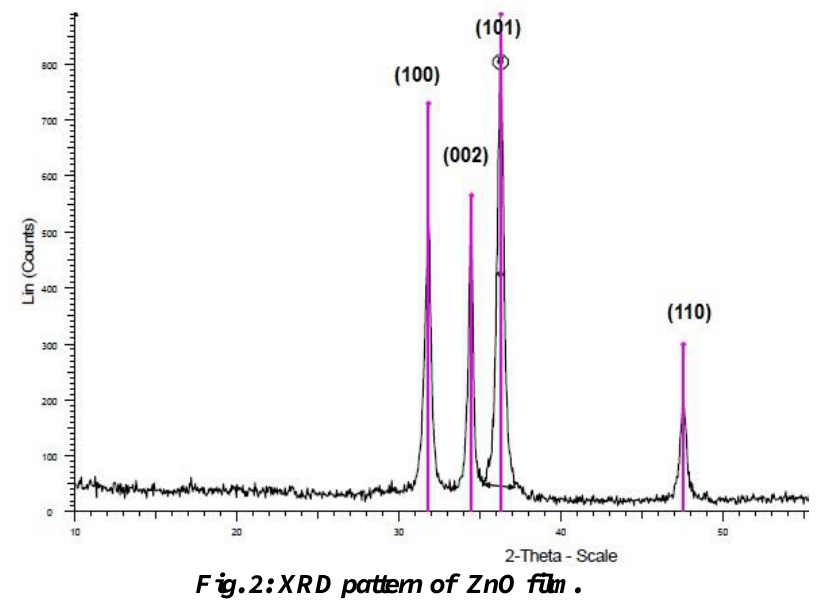
Fig. 2: XRD pattern of ZnO film.